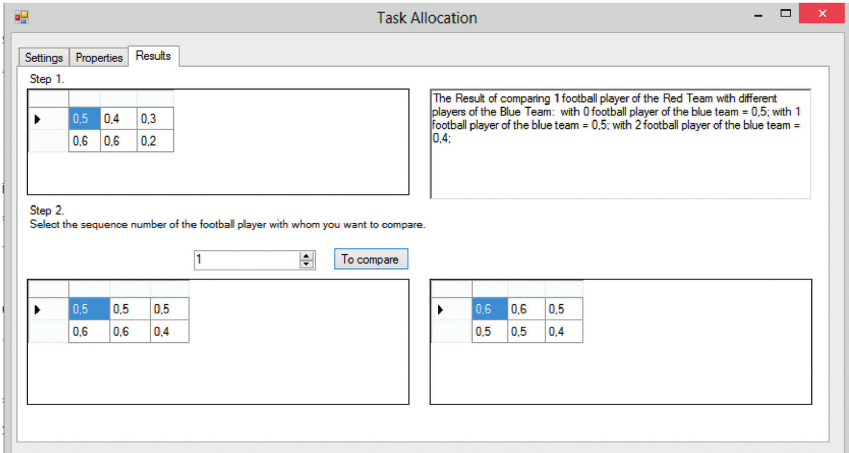
Figure 12: Obtained values of the comparison of the 1st mobile object of red with the blue ones and the identification of the most successful